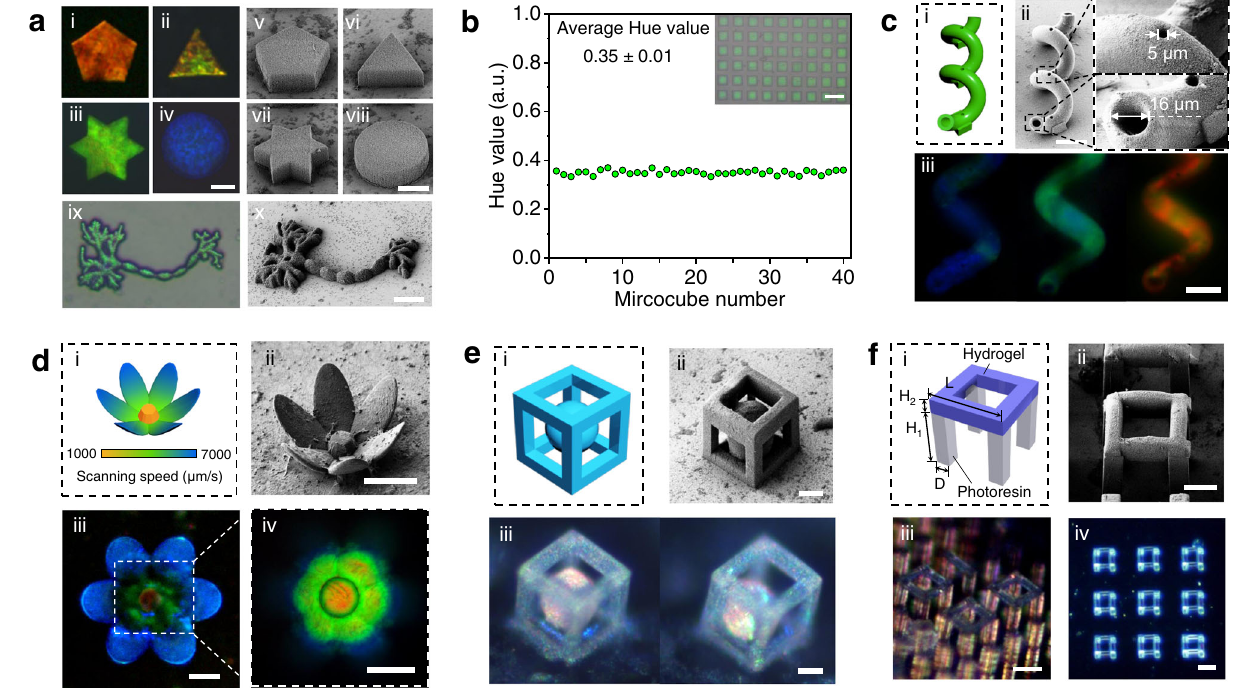
Fig. 4 | 2D and 3D microhydrogels fabricated via the sacri fi cial-scaffold- mediatedTPL.a 2Dcolloidalcrystalmicrostructureswithdifferentgeometriesand colors. (i – iv) Optical images and (v – viii) SEM images. (ix) Optical image of a microhydrogel with neuron cell geometry. (x) SEM image of the freeze-dried hydrogel. Scare bars: 20 μ m. b Reproducibility test, by printing a hydrogel micro- cube 54 times and measure their hue value (40 shown in the graph). Scare bar: 100 μ m. c (i) design, (ii) SEM image and (iii) optical images of 3D hollow spiral microtubes fabricated by our strategy. Scare bars: 40 μ m. d (i) design, (ii) SEM image and(iii,iv) opticalimagesof a multi-colorthree-dimensionalmicrohydrogel